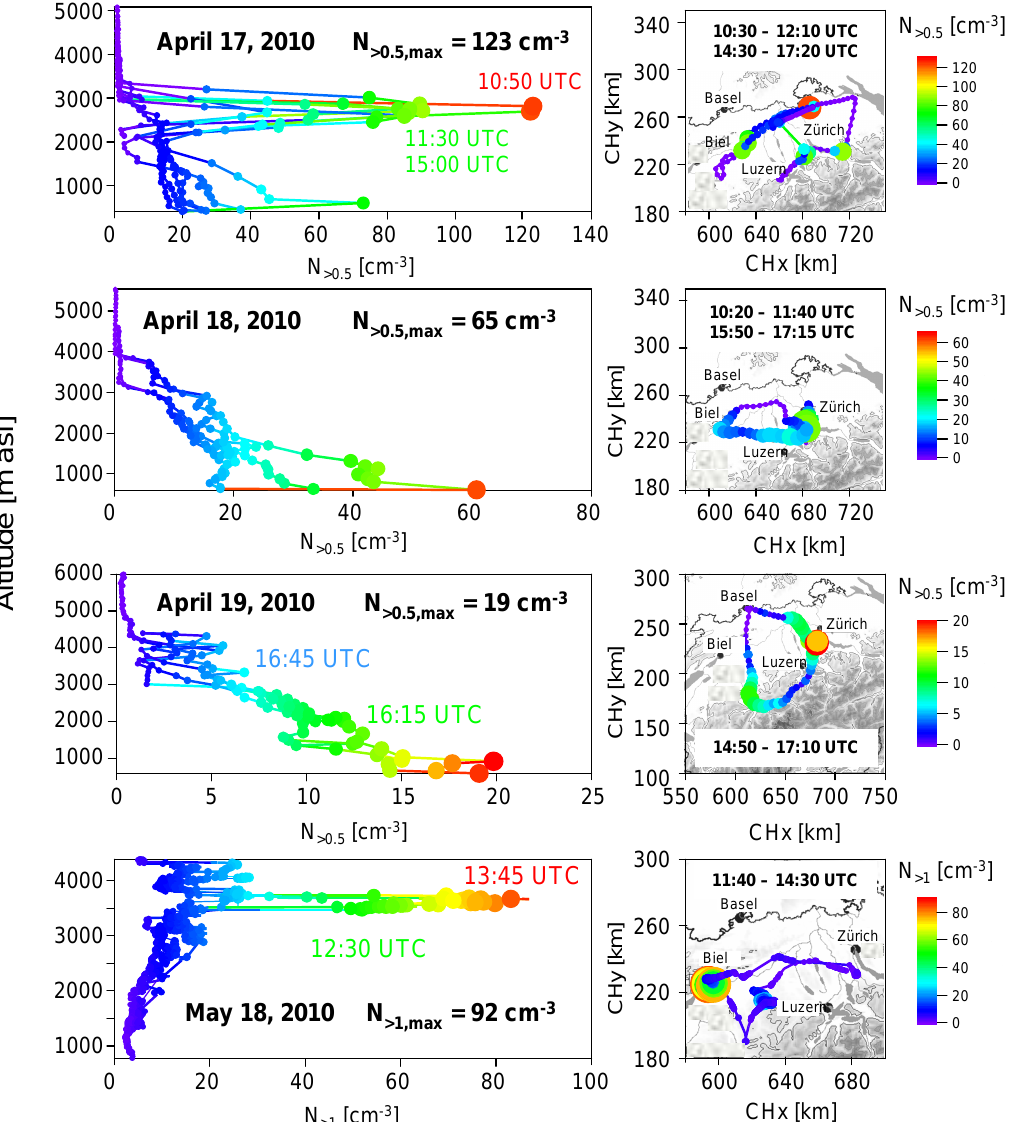
Fig. 11. In-flight number concentrations for particles with an optical diameter larger than 0.5µm ( N > 0 . 5 ) or 1µm ( N > 1 ), as a function of altitude (left panel) as well as geographical position and flight times (right panel). Data were corrected for sampling losses. CHx and CHy indicate the coordinates within the CH1903 coordinate system (TopoSwiss, 2010). The diameter size of the markers is proportional to the value of the displayed quantity. The Jungfraujoch is located South of the shown map